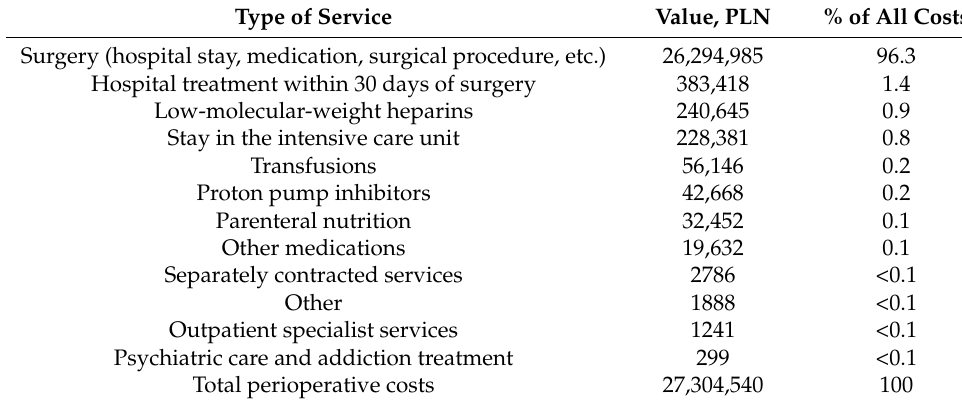
Table 1. Structure of total perioperative costs in the study